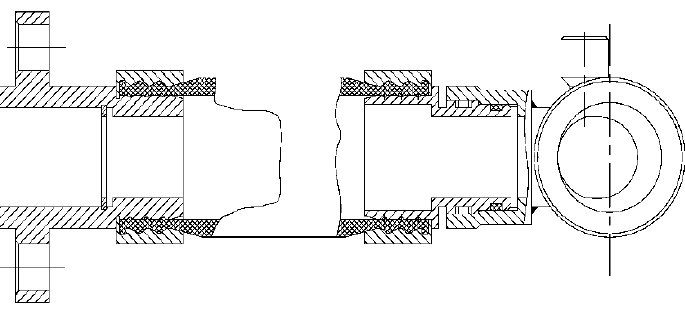
Figure 3. The structure diagram of double layer metal bellows (DLMB).